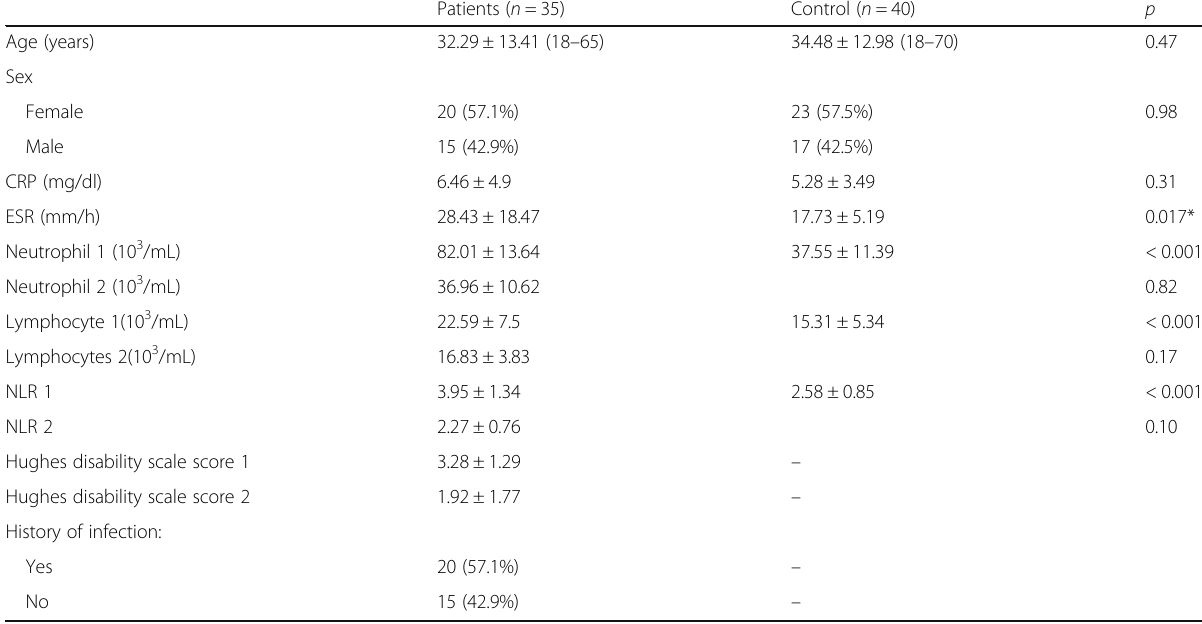
Table 1 Demographic data, clinical characteristic and blood biochemistry values of the studied groups Patients ( n =